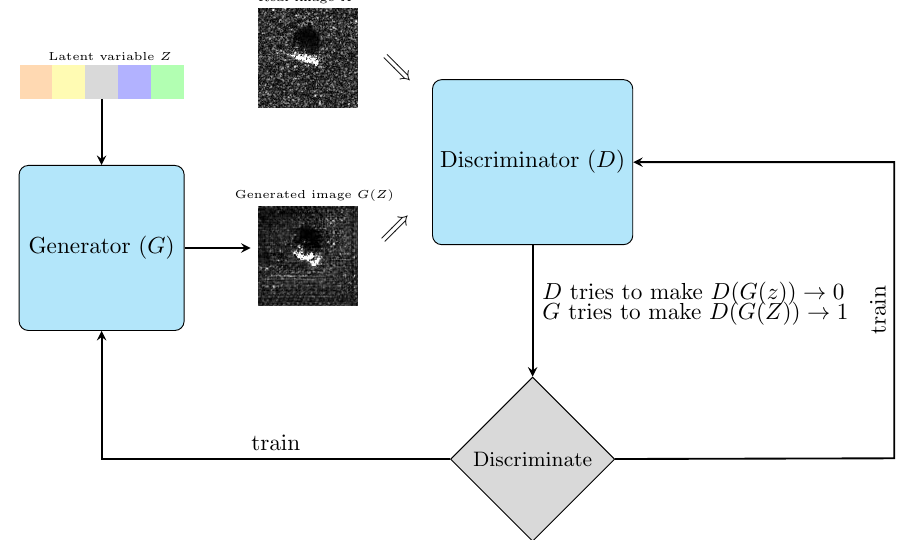
Figure 5. The schematic diagram of